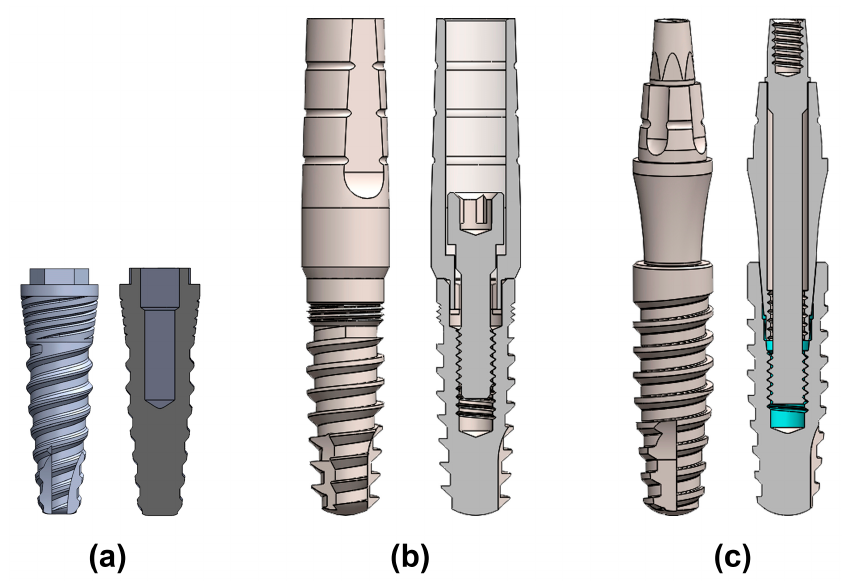
Figure 1. Schematic views of dental implant connections: ( a ) External connection ( b ) Internal connection ( c ) Morse taper connection.